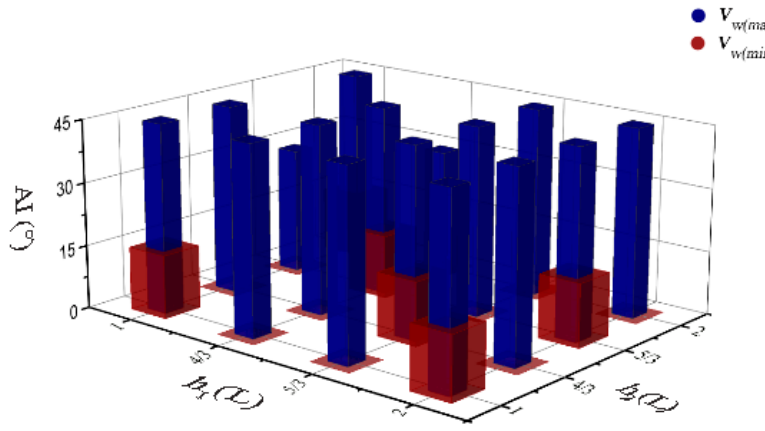
Figure 11. The maximum and minimum upwelling volumes of URs with different h 1 , h 2 , and AI .